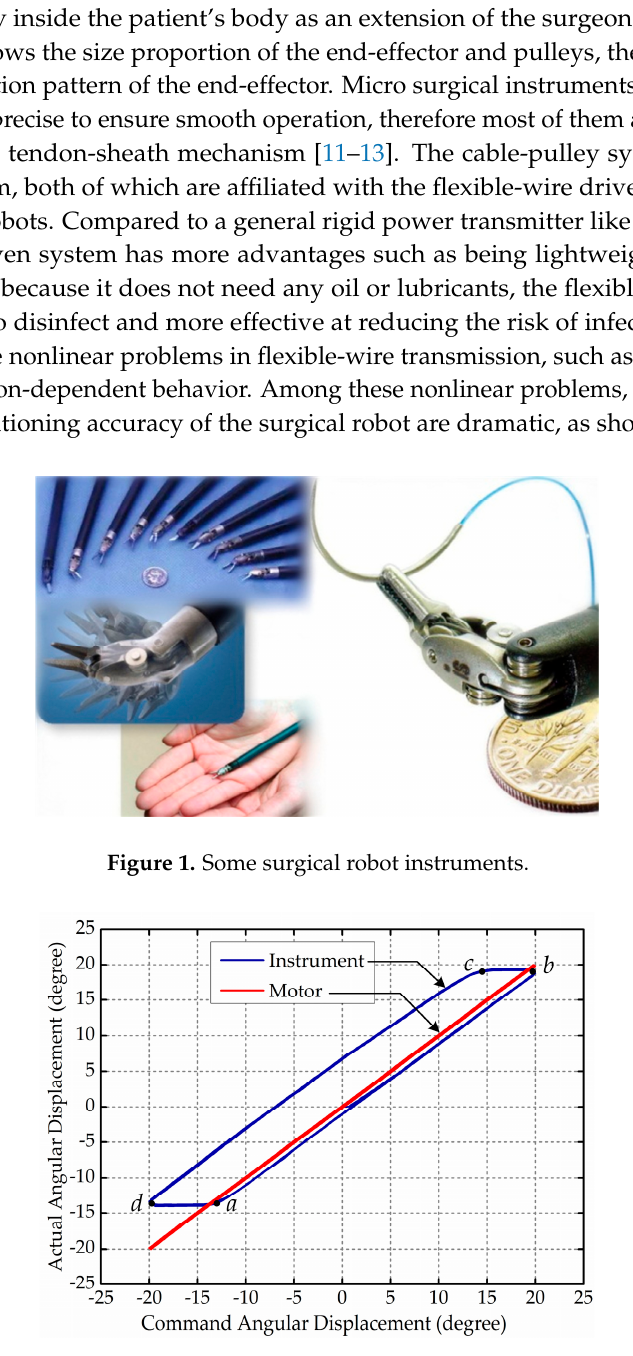
Figure 2. The relationship between actual and command angular displacement: segments ab and cd represent backlash hysteresis; segments bc and ad represent normal movement.